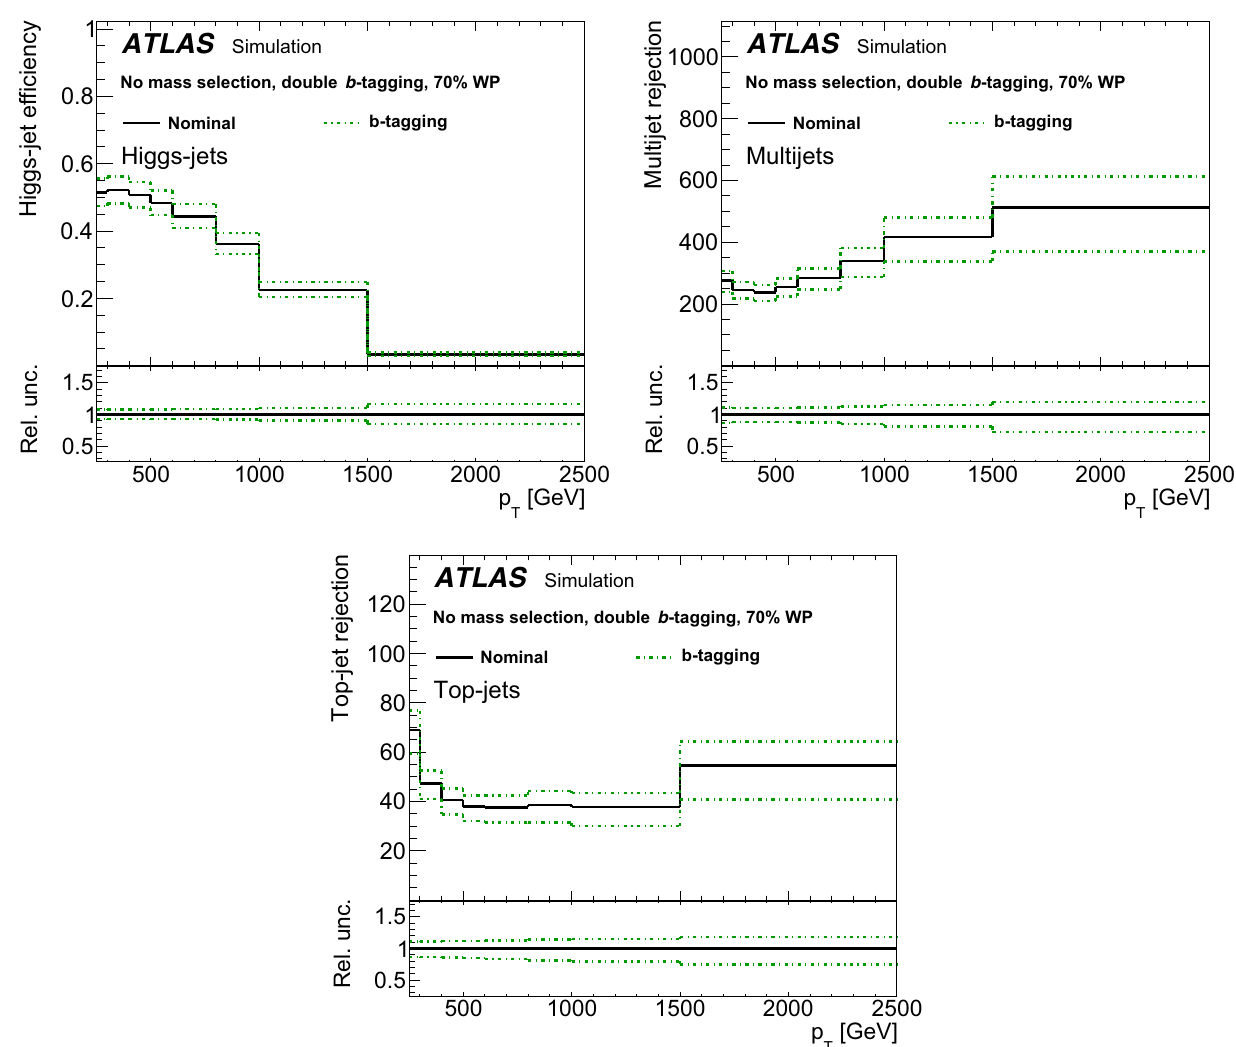
Fig. 2 The Higgs-jet efficiency (top left) and rejection against multijet (top right) and top-jet backgrounds (bottom) as a function of the jet p T for the 70% double- b -tagging working point. The nominal curves